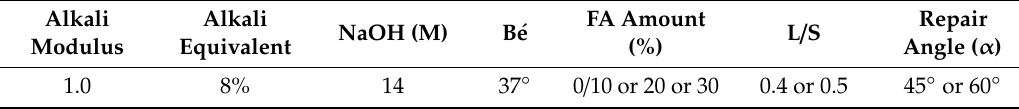
Table 2. Fly ash / ground-granulated blast-furnace slag geopolymer (FGG)